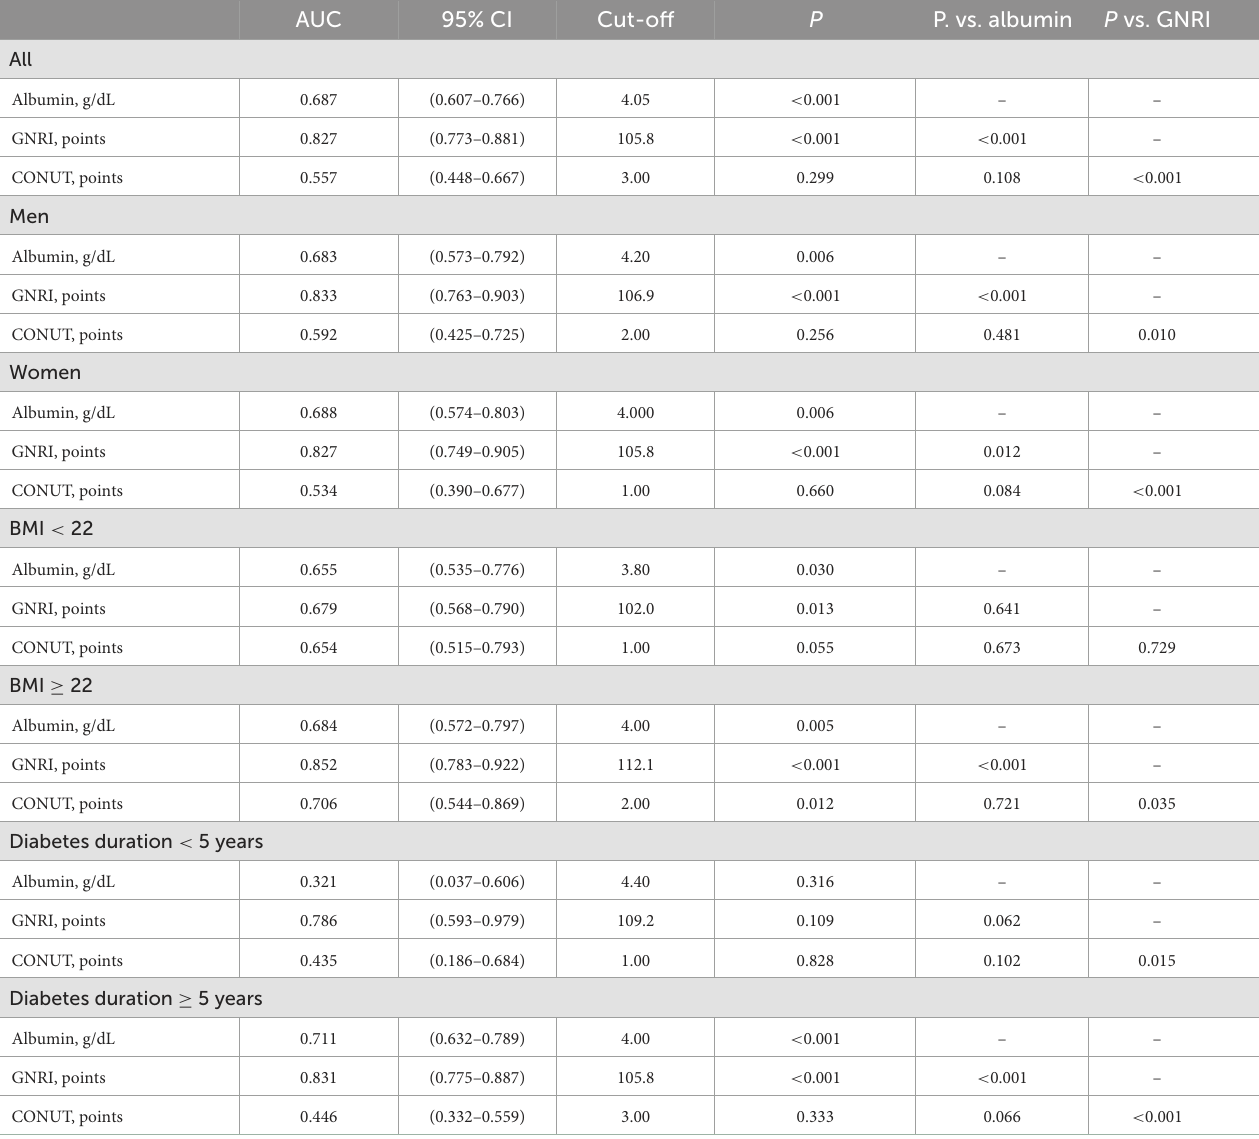
TABLE 3 Diagnostic value of the nutritional indexes for distinguishing between sarcopenia and non-sarcopenia. AUC 95% CI Cut-off